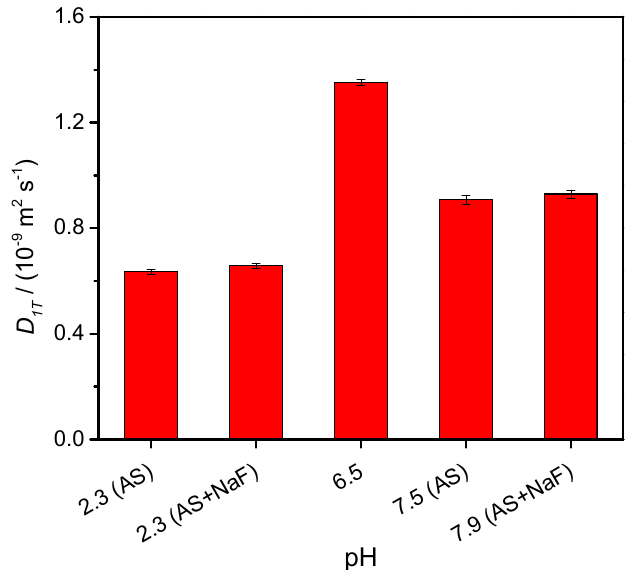
Figure 1. Tracer diffusion coefficients, D T , of NH 4 VO 3 in saliva artificial (AS) at different pH values , at 25.00 ◦ C. NaF represents sodium fluoride; pH = 6.5 is the value reached from the solutions obtained by dissolving NH 4 VO 3 in water.